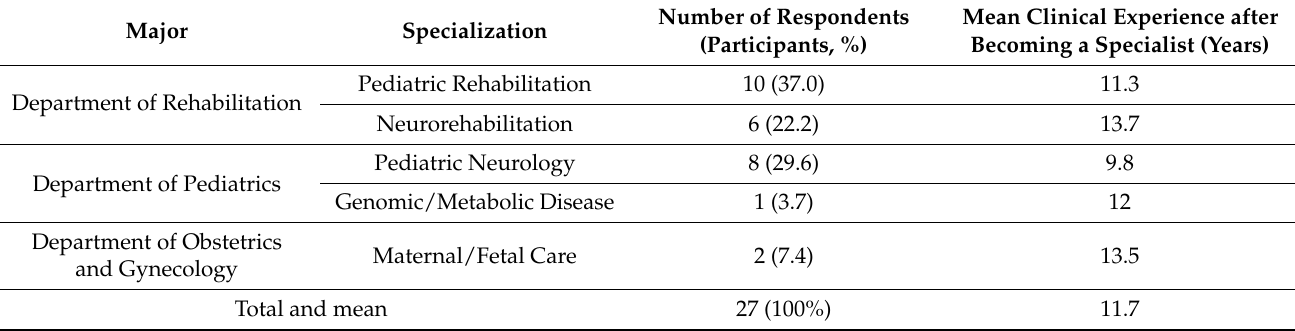
Table 1. General characteristics (N =